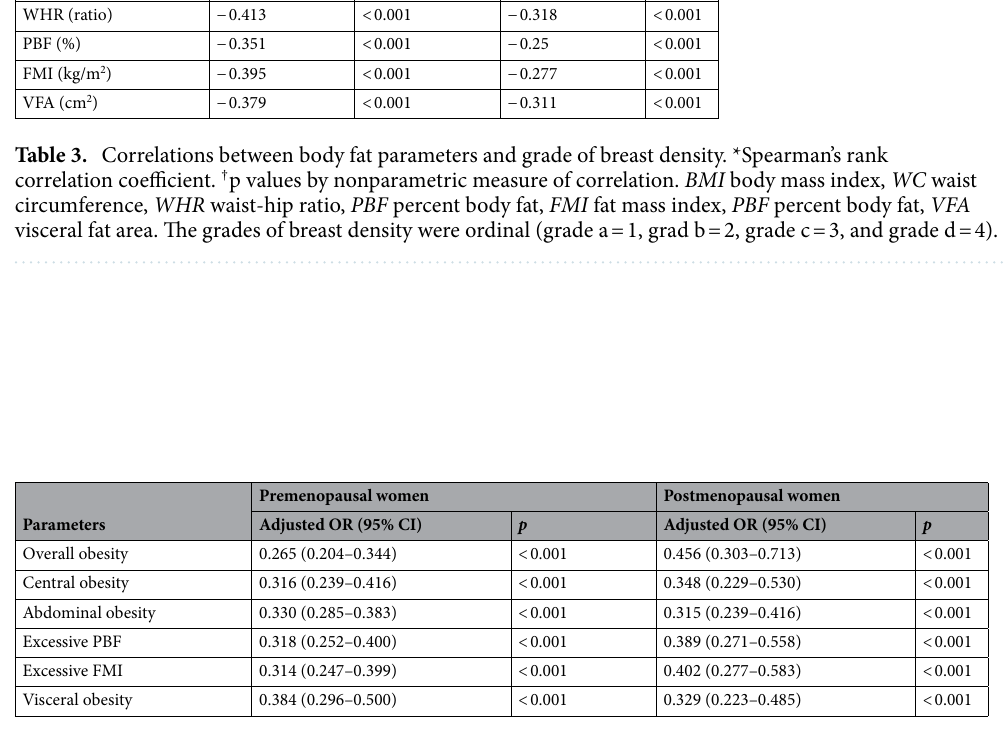
Table 4. Risk of the grade d (vs. grade a, b, or c) density according to body fat-driven obesity parameters using multivariable binary logistic regression. OR odds ratio, CI confidence interval. Overall obesity, BMI ≥ 25 kg/ m 2 ; Central obesity, waist circumference (WC) > 85 cm; Abdominal obesity, waist-hip ratio (WHR) > 0.85; The grade d of breast density, is extremely dense breast of BI-RADS; Excessive PBF, PBF ≥ 36.4% which is the highest quartile (Q4) of percent body fat (PBF) with reference to Q1, Q2, or Q3; Excessive FMI, FMI ≥ 8.85 kg/ m 2 which is the highest quartile (Q4) of fat mass index (FMI) with reference to Q1, Q2, or Q3; Visceral obesity, VFA ≥ 96.3 cm 2 which is the highest quartile (Q4) of visceral fat area (VFA) with reference to Q1, Q2, or Q3. Multivariable logistic regression model was applied with grades a, b, and c of BI-RADS as reference and adjusted for age, parity, smoking, alcohol, TG, HDL-C, fasting glucose, systolic BP, and diastolic BP in premenopausal